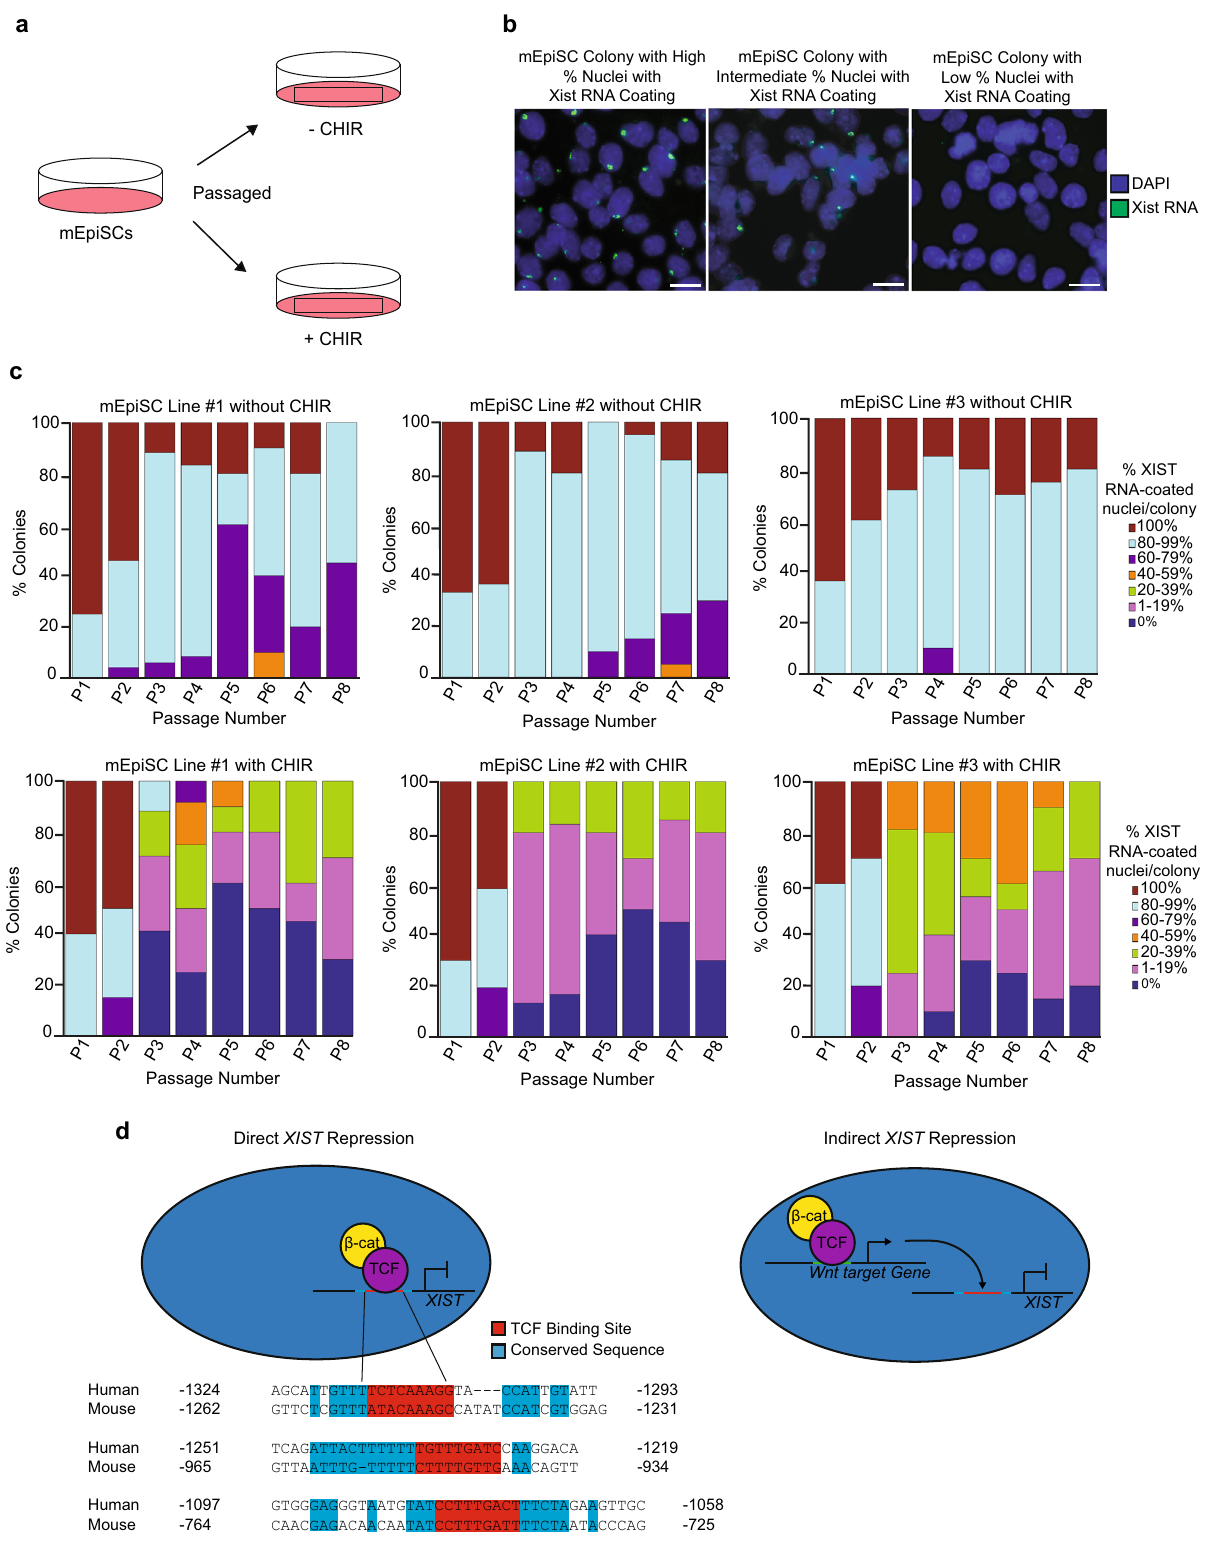
3 β and other components of the Wnt signaling pathway indirectly repress XIST by inducing the expression of genes that in turn silence XIST or by crosstalk with other signaling pathways that silence XIST 47,100,101 . Future work will dissect the direct vs. indirect regulation of XIST/Xist RNA expression by GSK-3 and Wnt sig- naling in